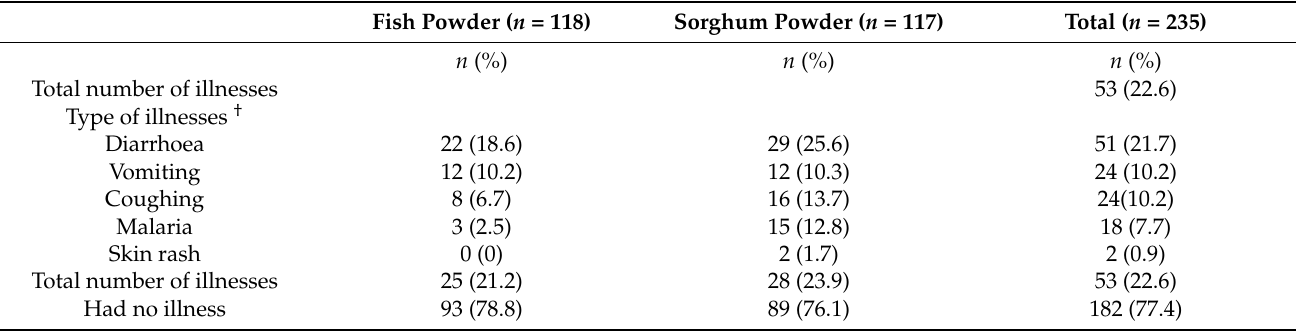
Table 8. Morbidities reported in the infants during the six-month intervention